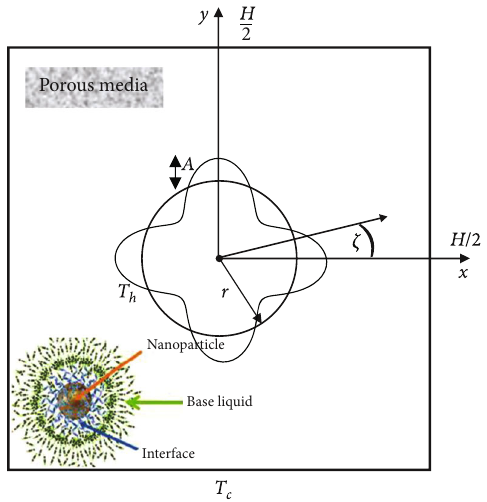
Figure 1: Diagrammatic illustration of the